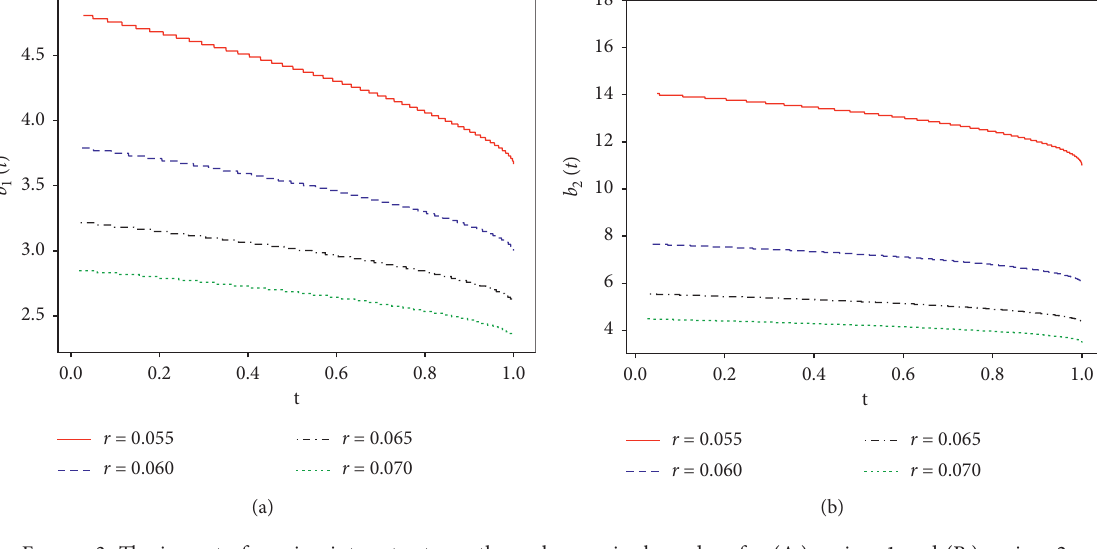
Figure 3: The impact of varying interest rate on the early exercise boundary for (A.) regime 1 and (B.) regime